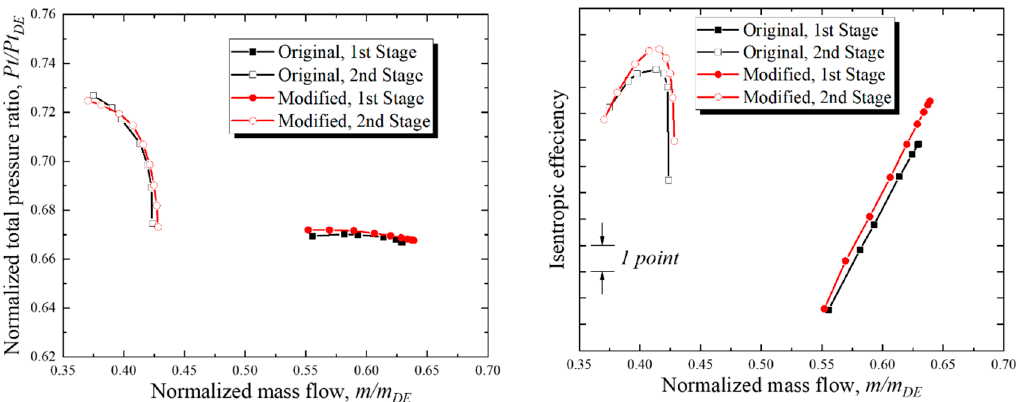
Figure 23. Characteristics of front and rear stages, 80% design speed.